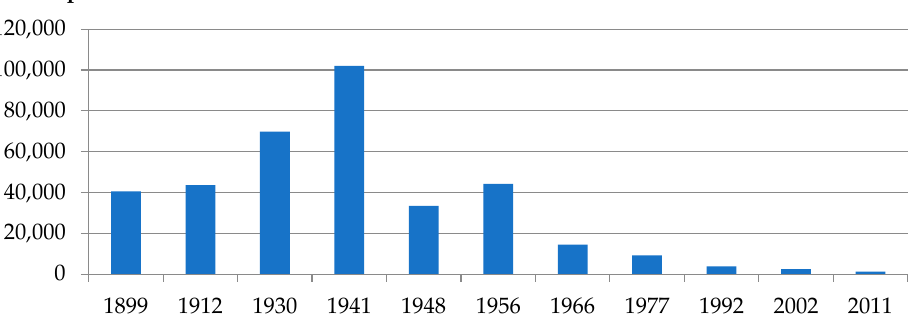
Figure 2. Demographic evolution of Jews in Bucharest (1899—2011). Source: processed data according to the Censuses of the Romanian population, 1899—2011 and according to the data of the partial Census from 1948.